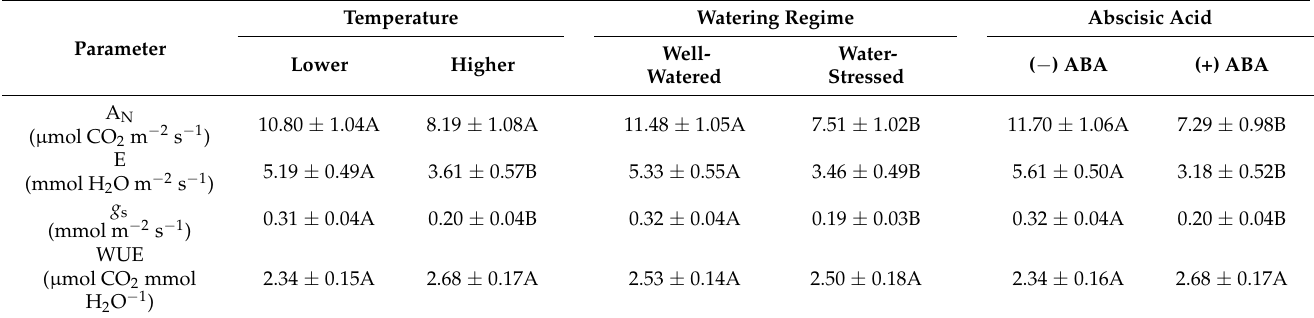
Table 10. Effects of temperature, watering regime, and abscisic acid on gas exchange of tomato